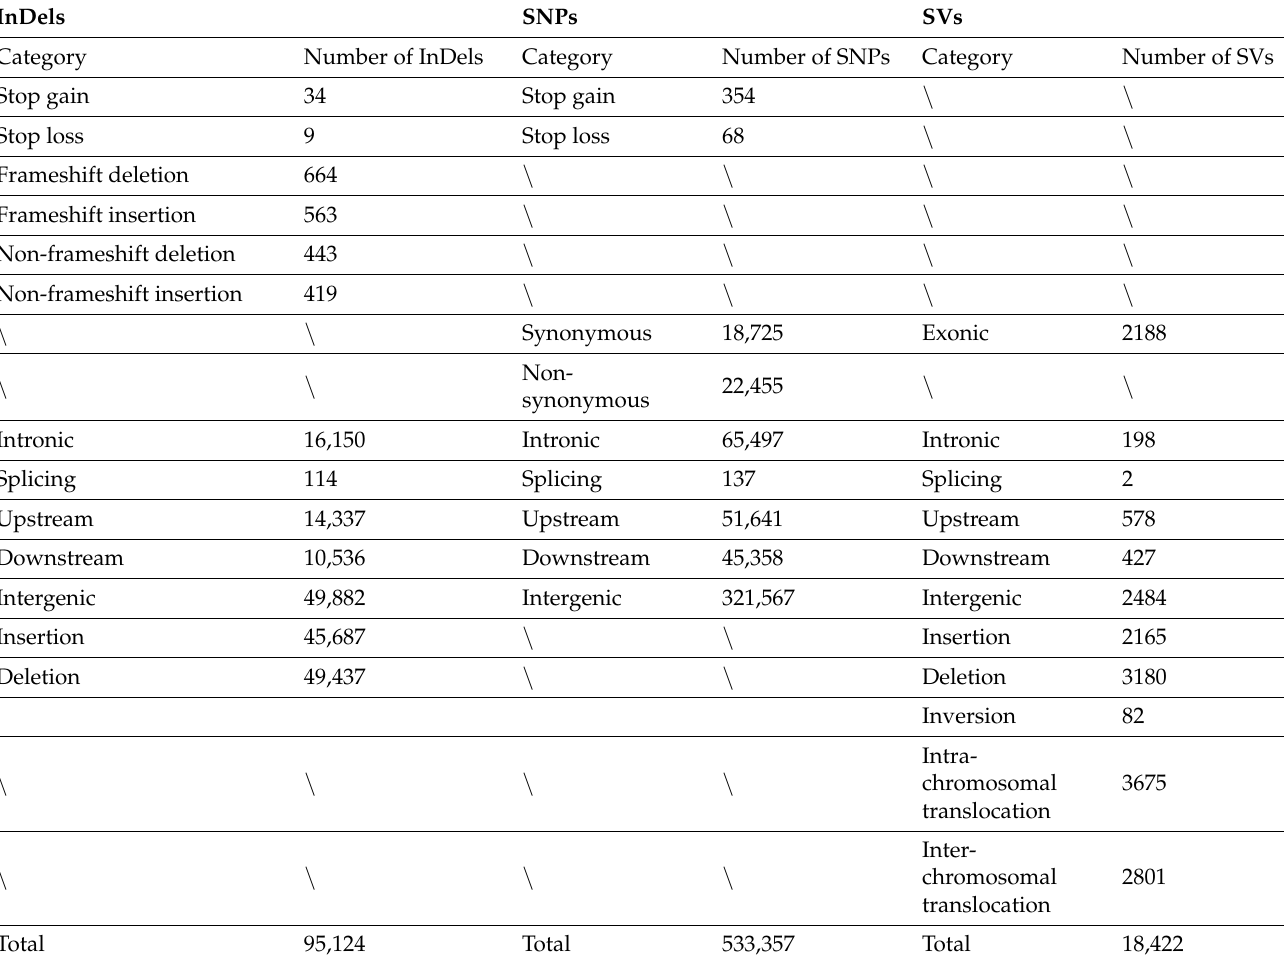
Table 1. Summary of genomic location of SNPs, InDels and SVs in ‘124 Pan’ genome.